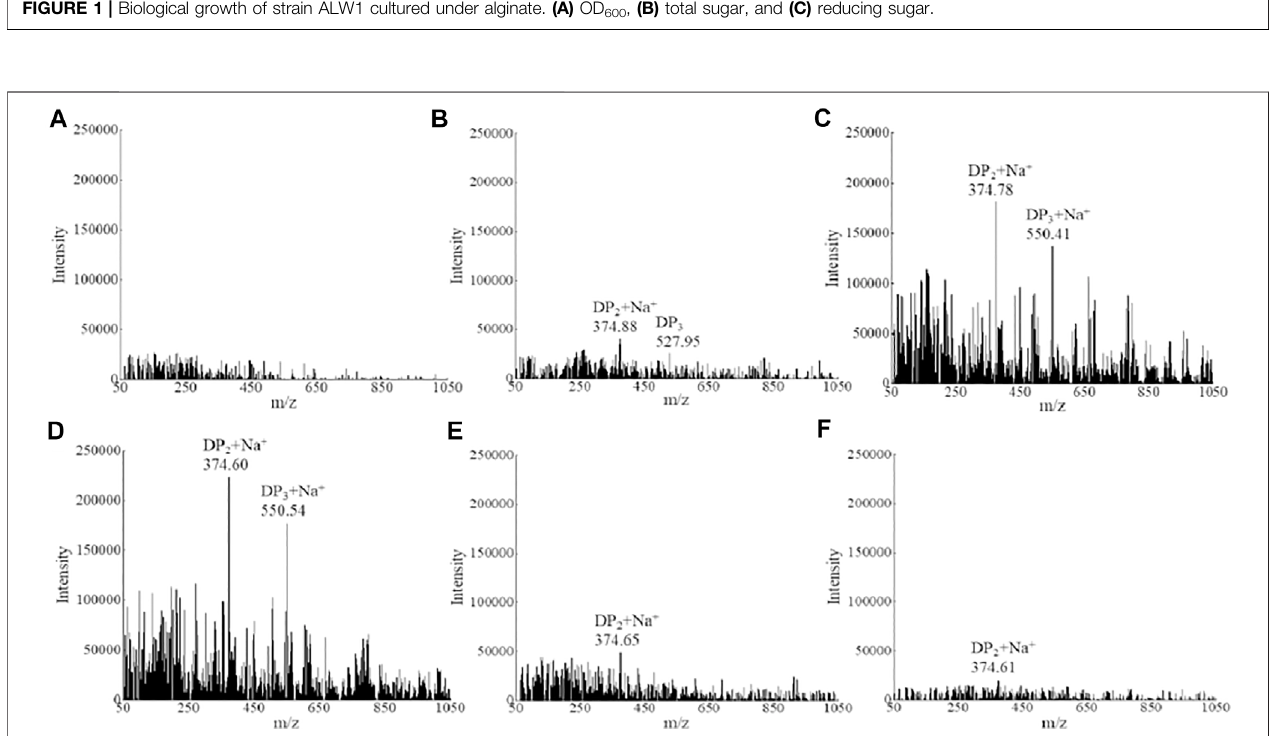
FIGURE 2 | Mass spectrometry analysis of alginate metabolism. (A) 0 h, (B) 4 h, (C) 8 h, (D) 12 h, (E) 24 h, and (F) 30 h.